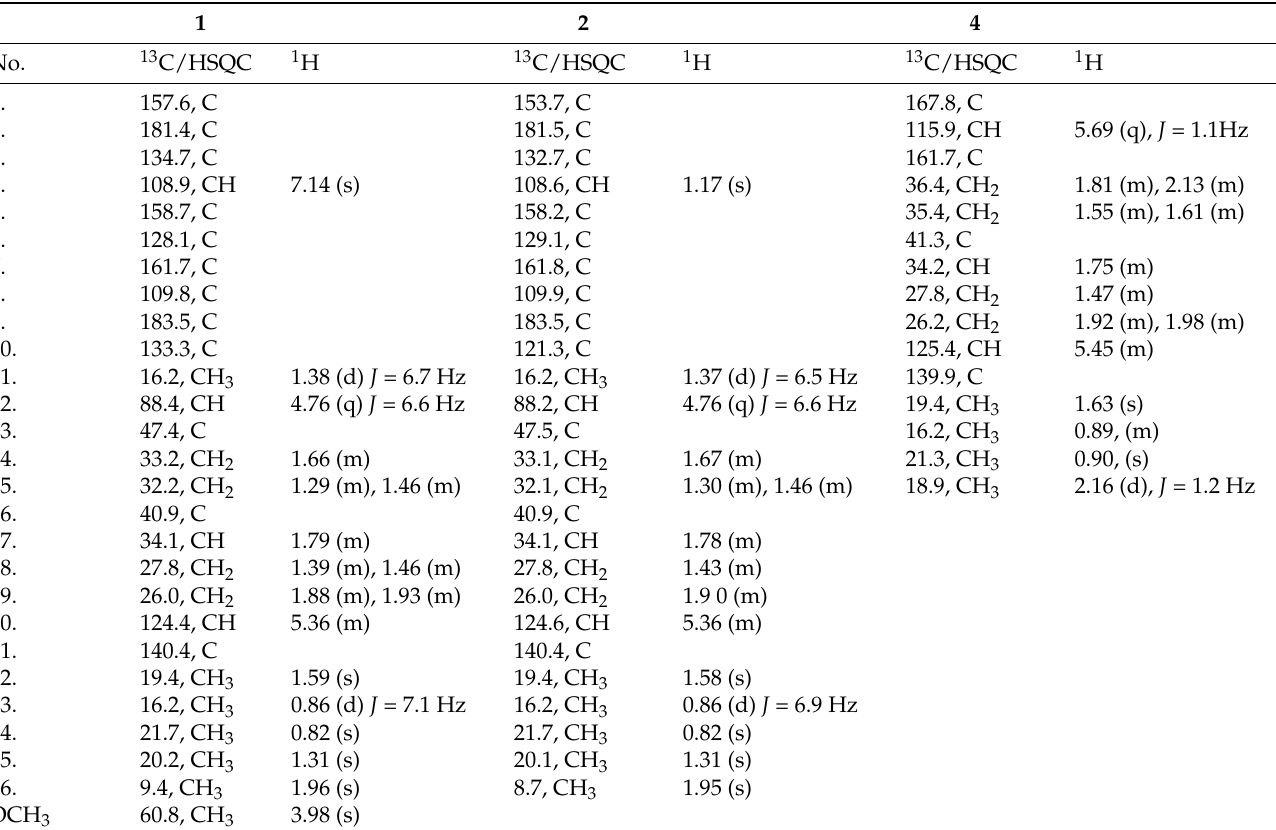
Table 1. NMR data for compound 1 and 4 ( 1 H 700 MHz, 13 C 175 MHz, in acetone-d 6 ) and 2 ( 1 H 500 MHz, 13 C 125 MHz, in acetone-d 6